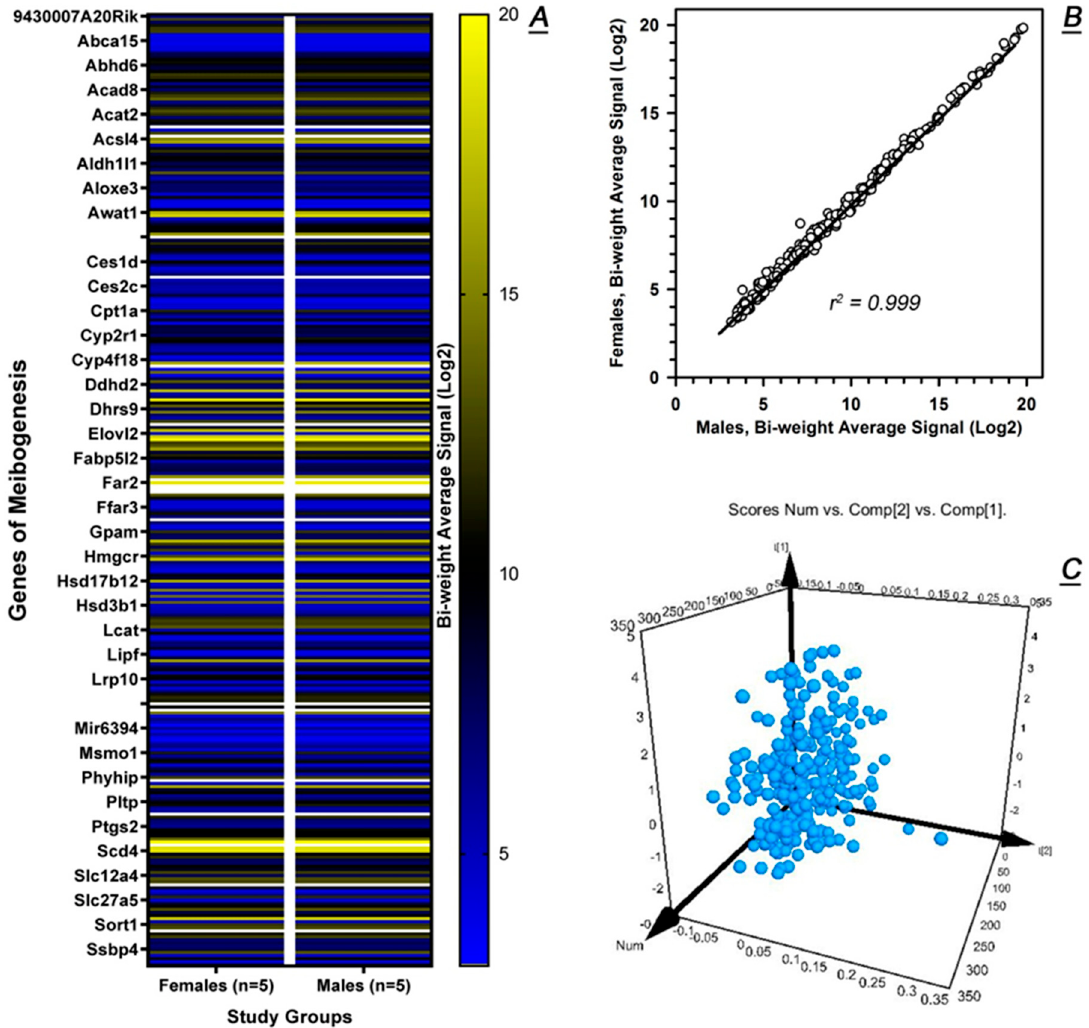
Figure 7. Targeted evaluation of the expression levels of 292 genes of meibogenesis in male and female tarsal plates ( n = 5 each gender, averaged). ( A ) Heat maps of the genes. Note the extremely high similarities between the genders. ( B ) A Log2 scatter plot of the gene expression levels in males and females. ( C ) (PCA) analysis of the gene expression data demonstrated tight clustering of the genes of meibogenesis, which indicates close similarities in the gene expression profile (GEP) of individual samples from both genders.